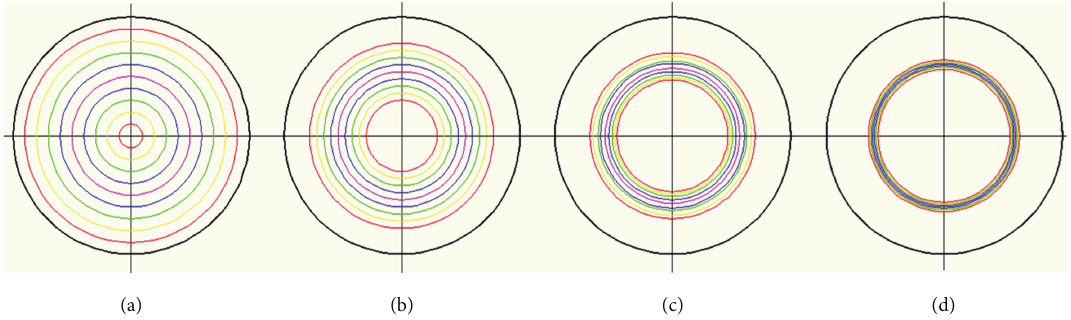
Figure 2: The contour lines of particle concentration in varying position of capillary. (a) 500 𝜇 m downstream, (b) 1000 𝜇 m downstream, (c) 2000 𝜇 m downstream, and (d) 4000 𝜇 m downstream.